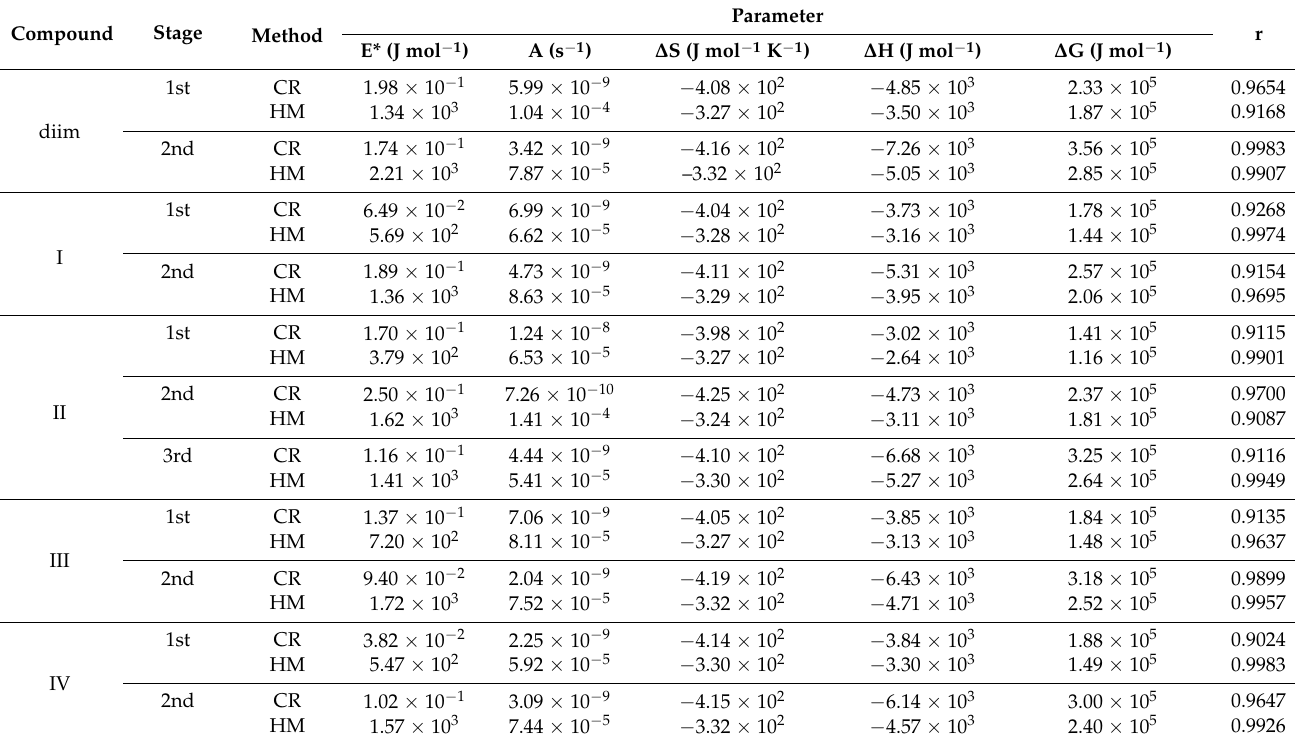
Table 4. Coats–Redfern (CR) and Horowitz–Metzger (HM) calculations for the MTSC and its metal complexes. Compound